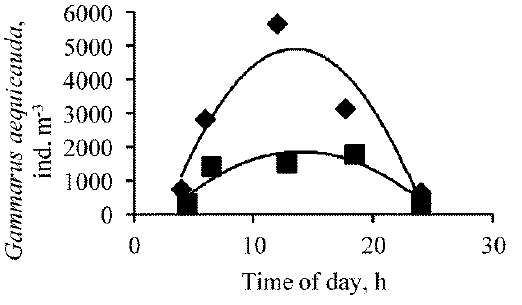
Figure 4. Diurnal changes of Gammarus aequicauda abundance in water columns in site 1 (rhombuses) and site 3 (squares) of Lake Moynaki during 15–16 September 2021.